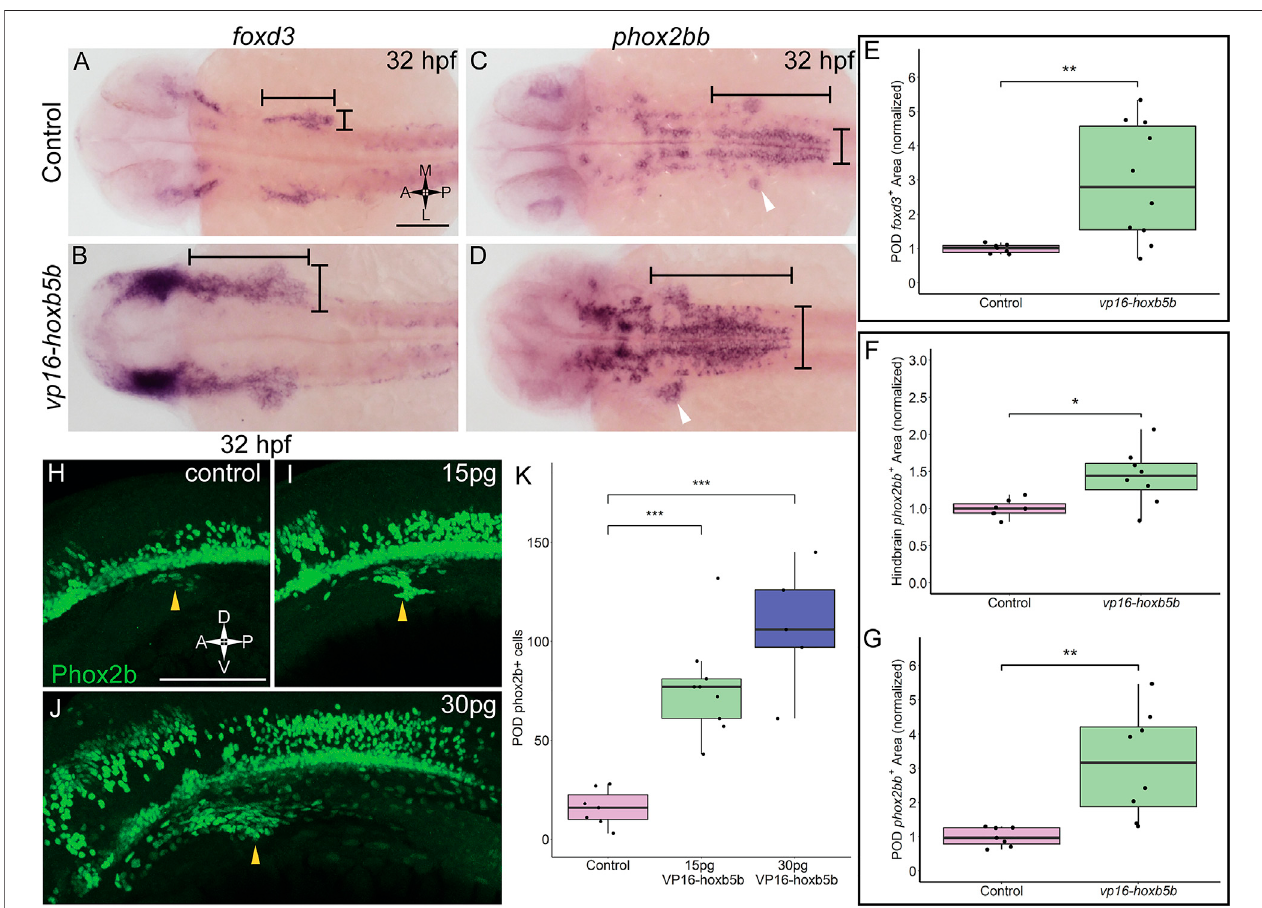
FIGURE 3 | Elevated Hoxb5b activity expands the expression domains of vagal markers foxd3 and phox2bb during the fi rst day in development. (A,B) in situ hybridization against foxd3 , a marker for multipotent NCCs at this stage, in 32 hpf embryos injected with 30 pg vp16-hoxb5b, were compared to WT controls. (C,D) in situ hybridizationagainst phox2bb ,anautonomicNCCmarker,in32 hpfembryosinjectedwith30 pg vp16-hoxb5b ,comparedtoWTcontrols.ThePODisdenotedwith a white arrow head. (E – G) Quanti fi ed POD foxd3 expression area (E, control n (cid:1) 7; vp16-hox5b n (cid:1) 10; p (cid:1) 0.00571) or phox2bb expression area (F, control n (cid:1) 7; vp16-hox5bn (cid:1) 8; p (cid:1) 0.138),asnotedinrepresentativeimagesbyblackbars.ThediscretePODexpressiondomainisquanti fi edfromthesesameembryosasshownin (G) ( p (cid:1) 0.00563). Areas are normalized to control mean. (H – K) IHC detection of Phox2b + cells viewed along the lateral axis of 32 hpf embryos reveal that WT controls ( n (cid:1) 7)alreadyhaveanascentpopulation[ (H) ,whitearrowheads]. vp16-hoxb5b overexpression,ateither15 pg[ (I) , n (cid:1) 9]or30 pg[ (J) , n (cid:1) 5]ofmRNAinjected,expands the Phox2b + vagal NCCs (white arrowheads). (K) Counted Phox2b + cells from 3 dimensional micrographs reveal increasing cells with the amount of